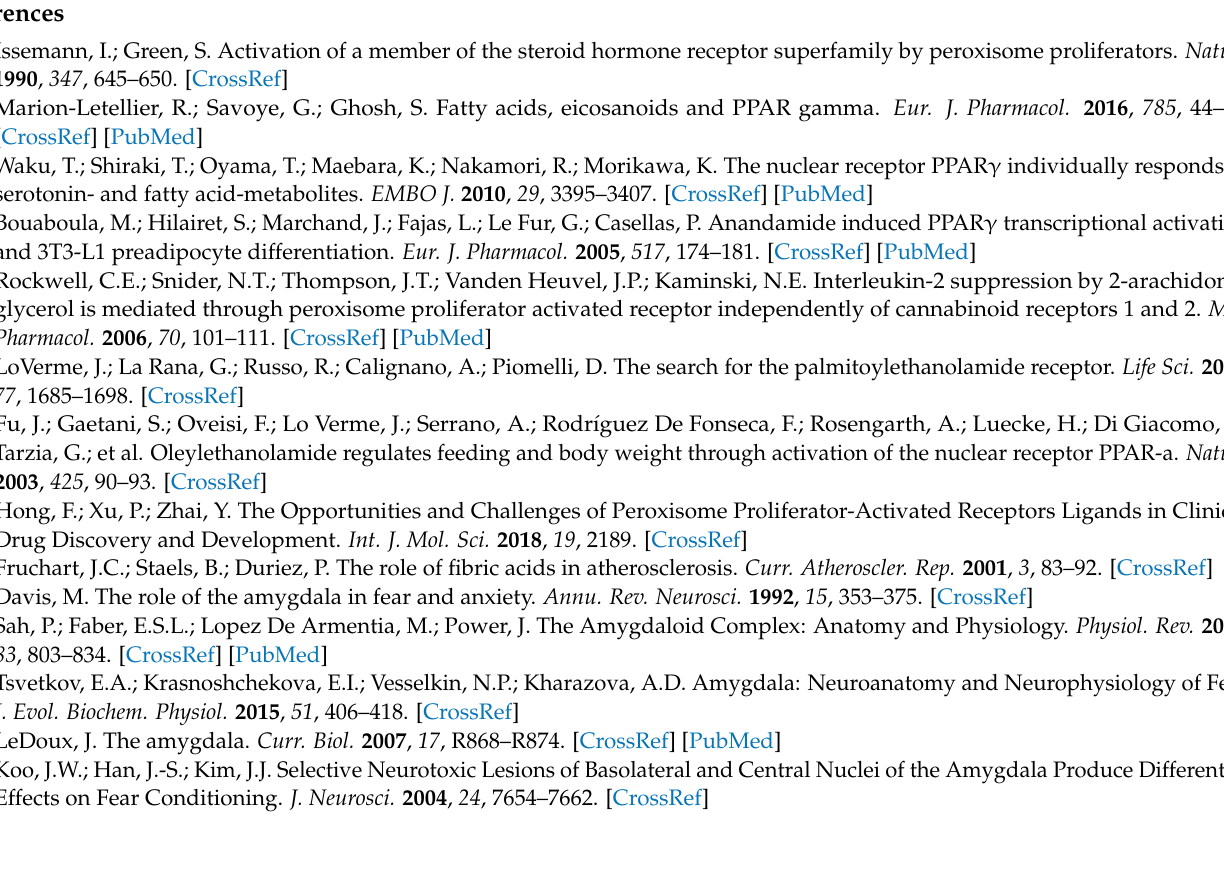
synthesis; Table S3: Supplementary Table S3: Master mixture 2 for cDNA synthesis; Annex